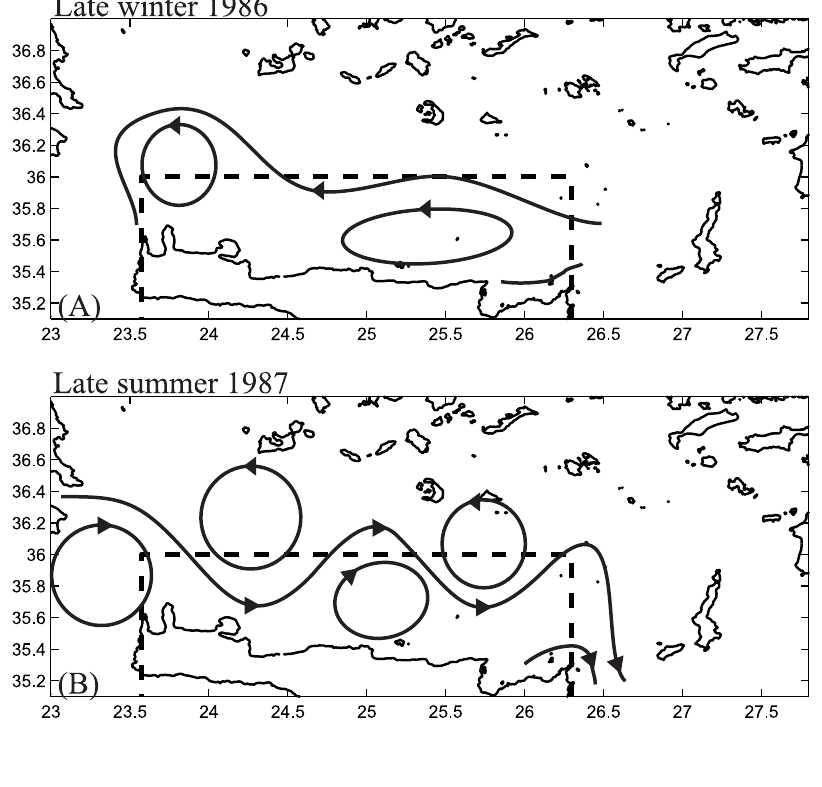
Fig. 4. Schematic configurations of the main circulation features for (a) late winter 1986, and (b) late summer 1987. (After Theocharis et al.,